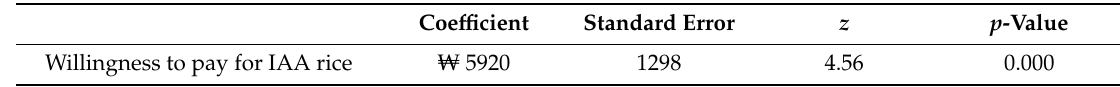
Table 6. Willingness to pay for IAA